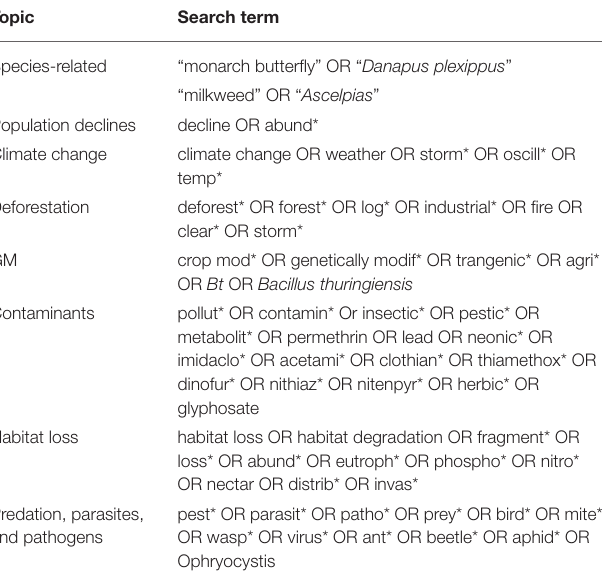
TABLE 1 | Summary of search terms associated with the declines in the eastern migratory North American population of monarch butterflies ( Danaus plexippus ) used in the comprehensive literature review using Web of Science TM